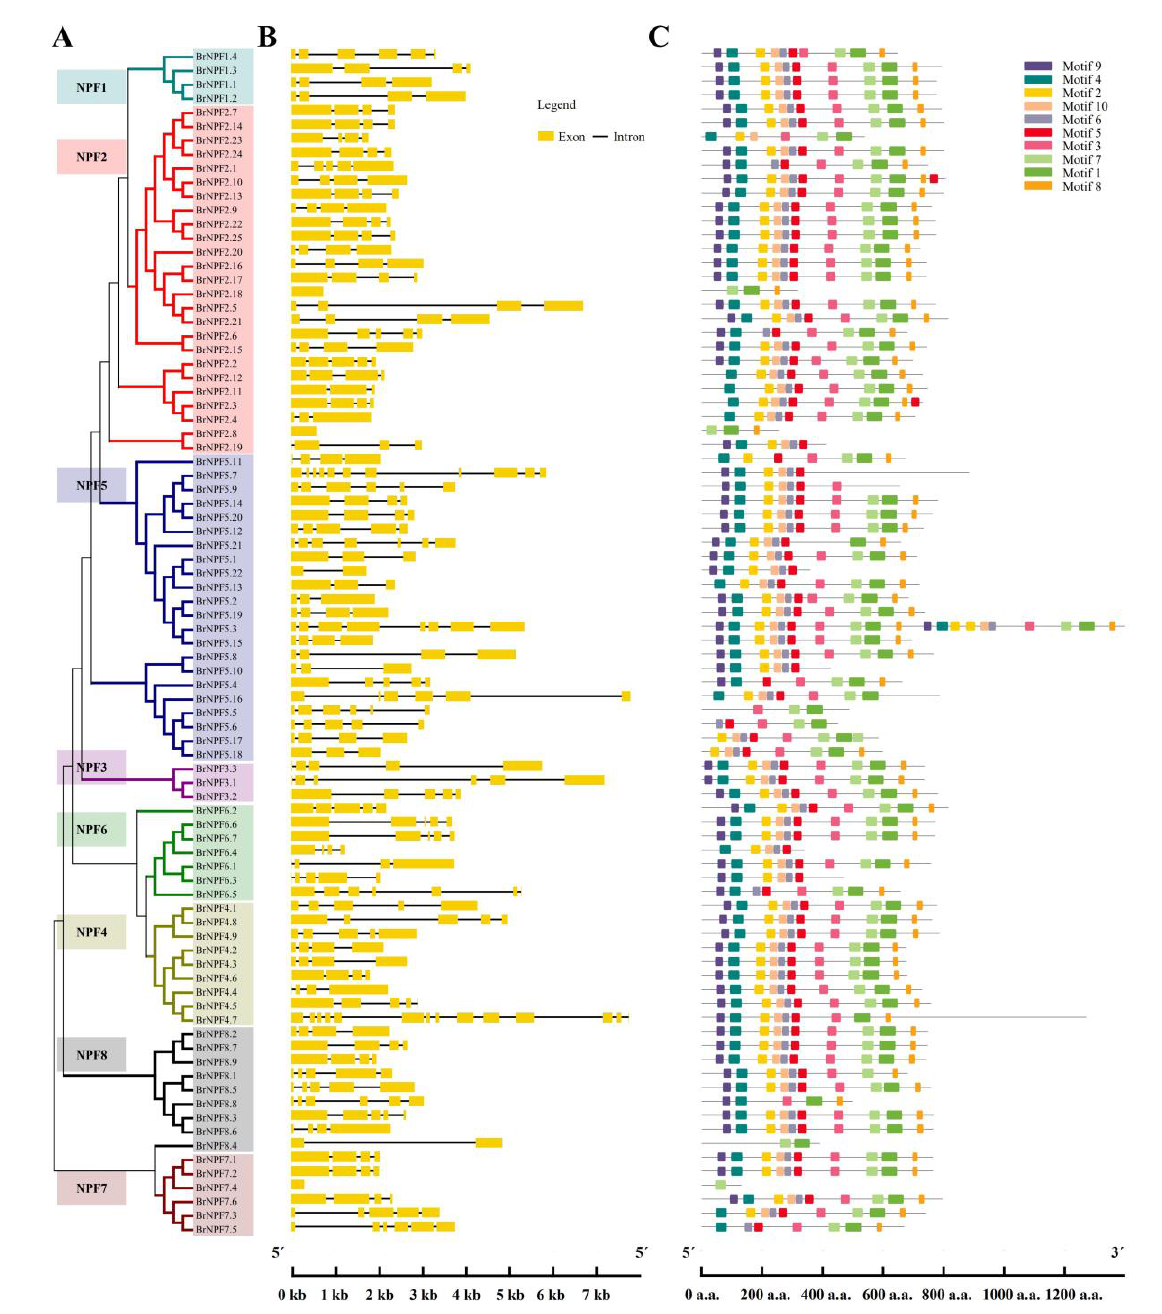
Figure 2. Phylogenetic tree ( A ), gene structures ( B ), and MEME motifs ( C ) for 85 NPFs identified in B. rapa . ( B ) Yellow boxes represent exons, and black lines indicate introns. ( C ) The colored boxes indicate motifs, as shown by the legend on the right.